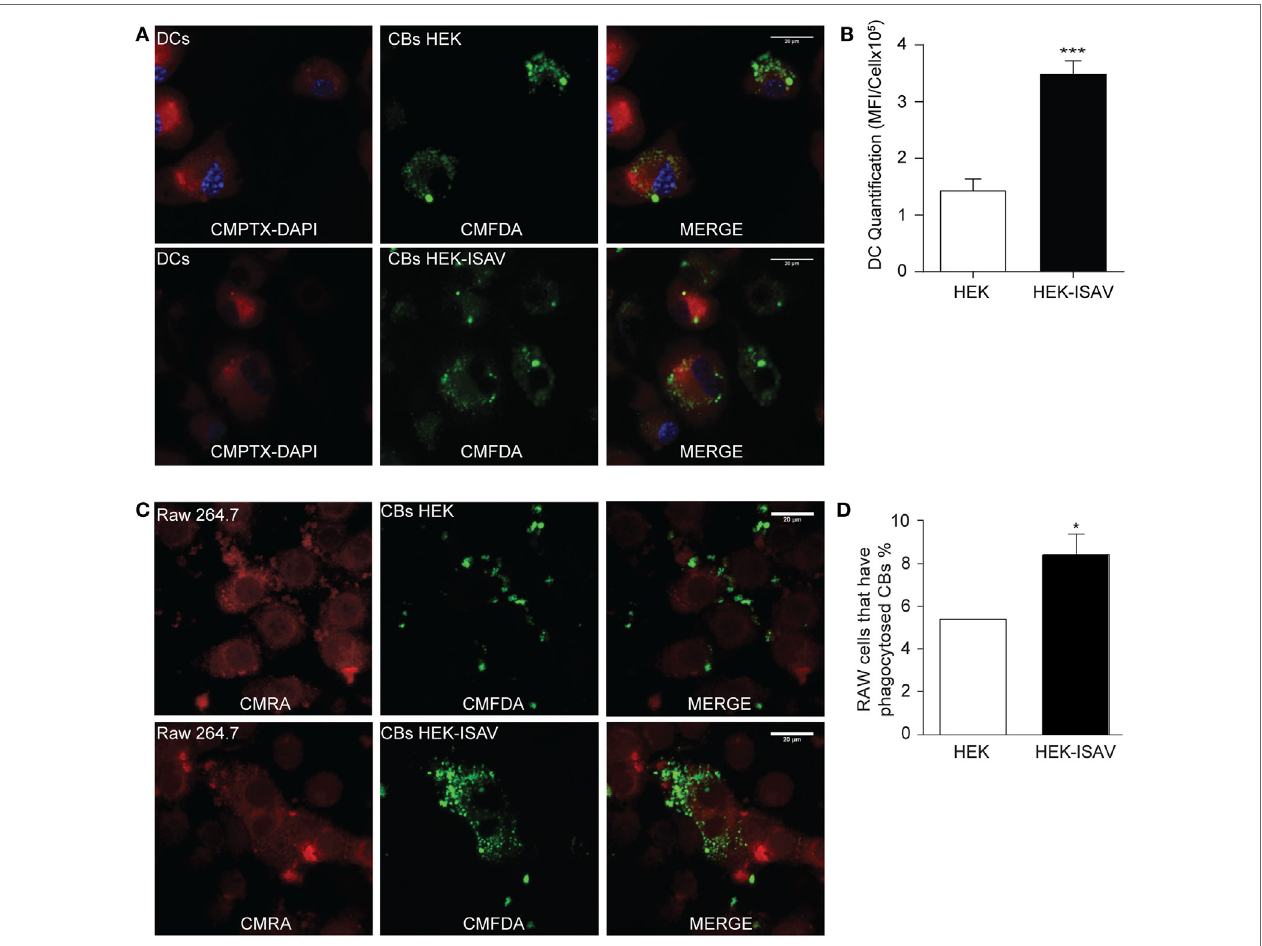
FigUre 2 | Fusion protein infectious salmon anemia virus (ISAV) facilitates antigen transfer to antigen presenting cells. (a) Phagocytosis of fluorescent cell bodies (CBs) by dendritic cells; the top panel shows dendritic cells in the presence of non-transfected CBs; the bottom panel shows dendritic cells in the presence of CBs transfected with ISAV. (B) Quantification of mean fluorescence intensity of CBs in the cytoplasm of DCs (c) Phagocytosis of fluorescent CBs by Raw.267; the top panel shows Raw.267 in the presence of non-transfected CBs, the bottom panel shows Raw.267 in the presence of CBs transfected with ISAV. (D) Quantification of RAW.264.7 cells percent that have phagocytosed fluorescent CBs ( n = 7). Statistical analyses were performed using the Mann–Whitney test (* p < 0.05, *** p <